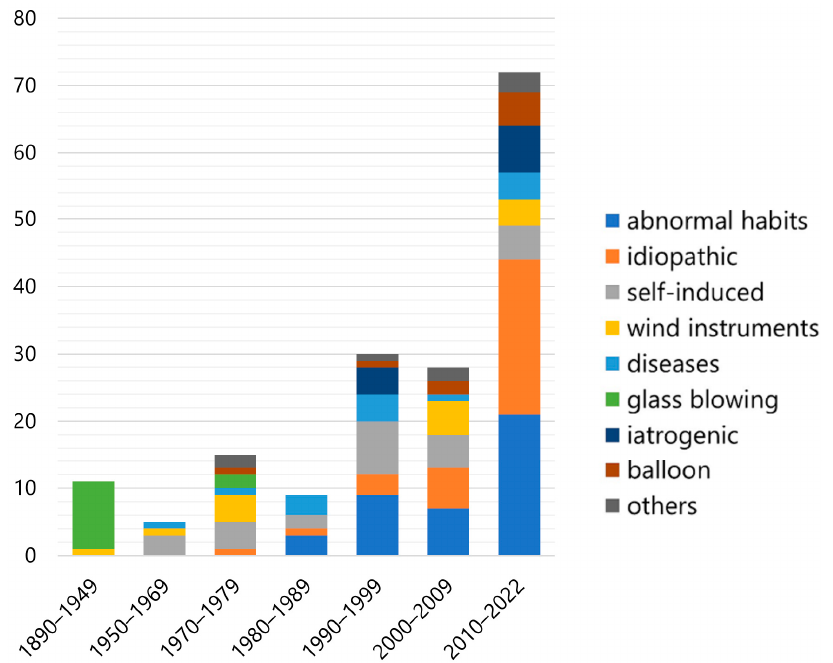
Figure 6. Changes in the number of patients for each etiology of pneumoparotid during the past 130 years.